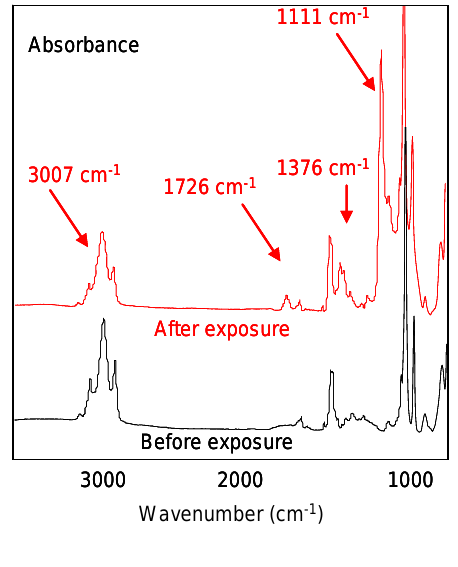
Figure 6. FTIR spectra of a polybutadiene film before and after exposure to 100 ppbV ozone during 2